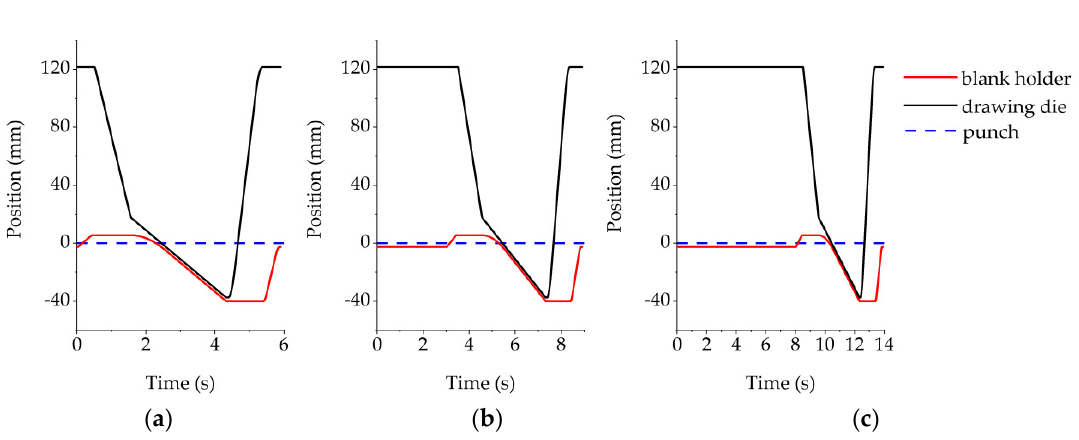
Figure 15. Motion profile of blank holder and drawing die in the press while forming in comparison to the constant top level of the punch at 0 mm (reference height) for different soaking time intervals: case ( a ) immediate transfer, case ( b ) after 3 s, and case ( c ) after 8 s.